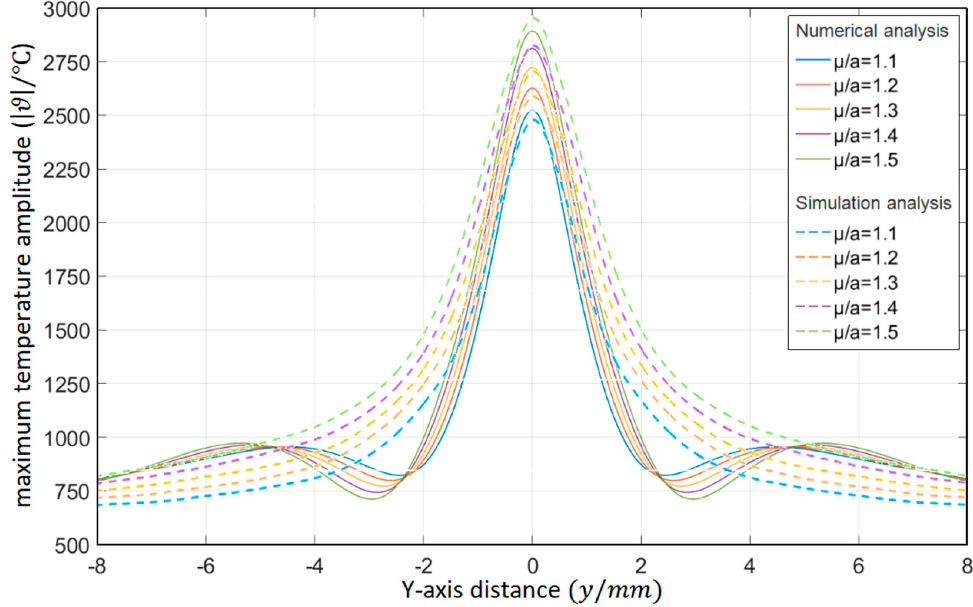
Figure 13. Influence of the relative thermal diffusion length on the temperature distribution in the Y -axis direction (ANSYS). Table 6. Parameters of circular hole and incident light source in the fifth simulation.